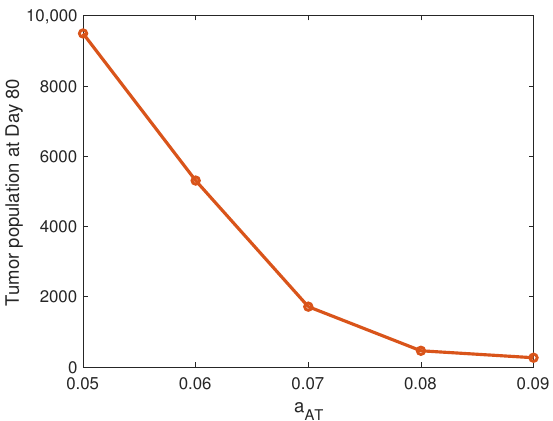
Figure 4. Tumor-mediated T cell proliferation. This figure depicts the mean tumor population at Day 80, as a function the tumor-mediated T cell proliferation rate, a AT . Means are calculated from 10 simulations performed for a AT = [ 0.05,0.06,0.07,0.08,0.09 ] , with k TA = 0.03 and all other parameters set at their baseline levels.